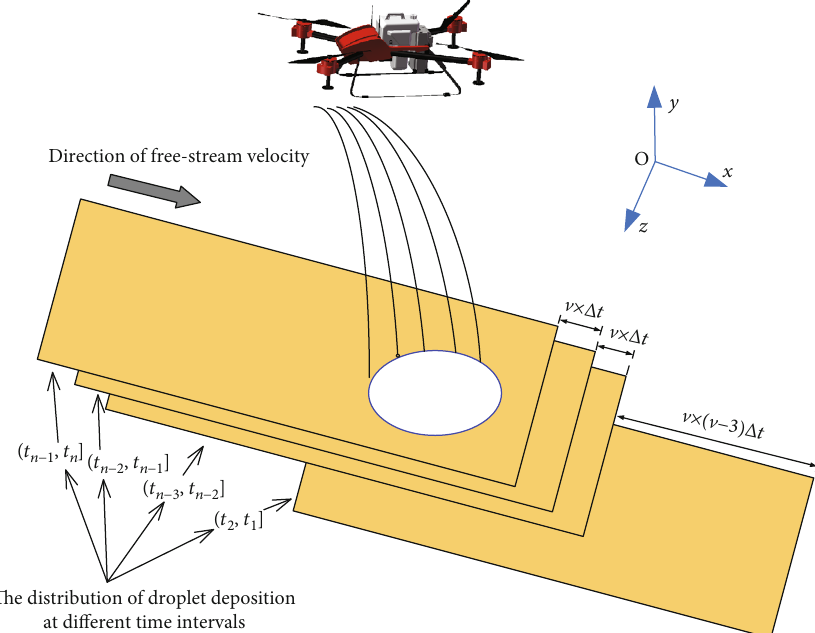
Figure 5: The schematic diagram of conveyor belt model for droplet deposition.